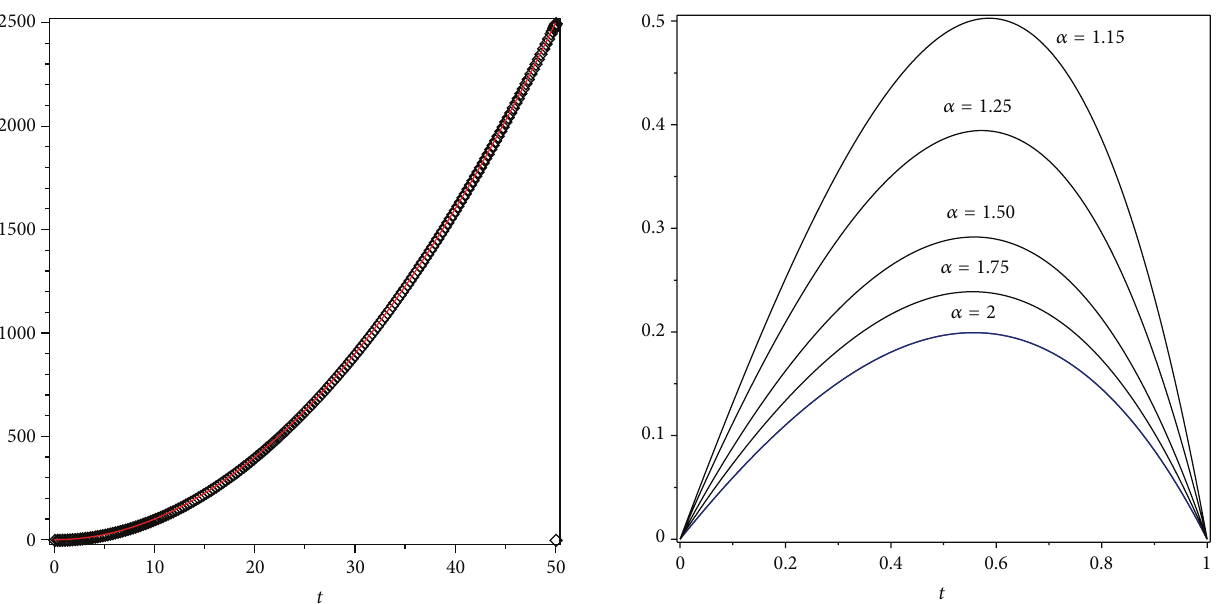
Figure 4: Approximate and exact solutions for Example 4 in the interval [0,50] .